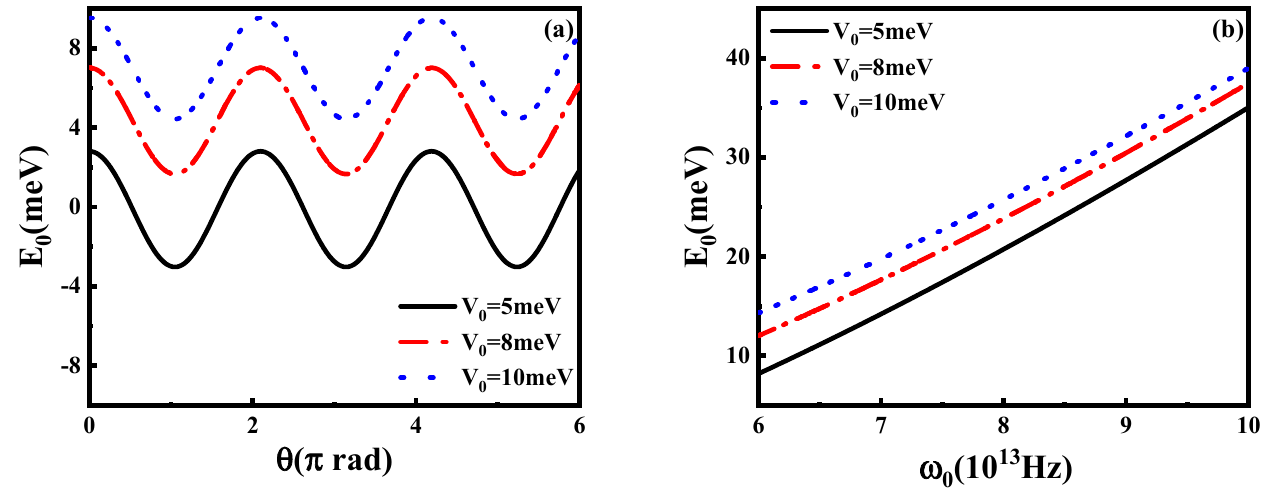
versus ( a ) polar angle θ and ( b ) confinement strength ω (cid:2868)